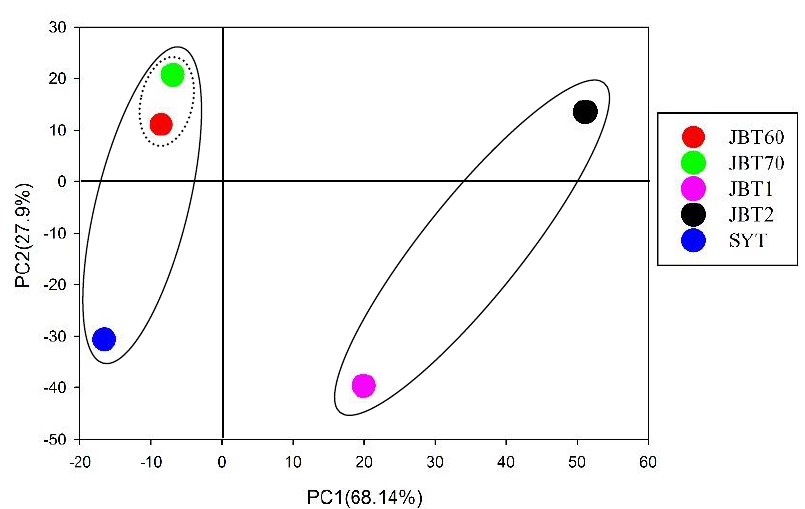
Figure 3. The principal component analysis of samples at the genus level. Principal component 1 and 2 explained 68.14% and 27.9% of the total variations, respectively. Based on PC1, JBT1/2 were clustered together, JBT60/70 and SYT were in the same group (solid lines). JBT60/70 and SYT were further divided into two groups (dashed